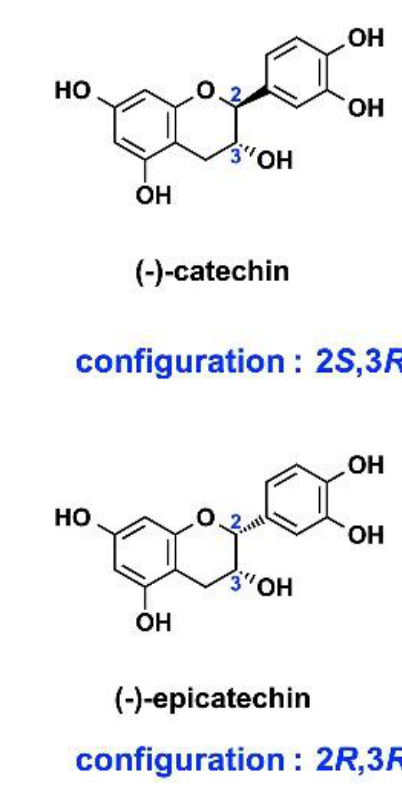
Figure 4. Structures of the six tested flavan-3-ols.